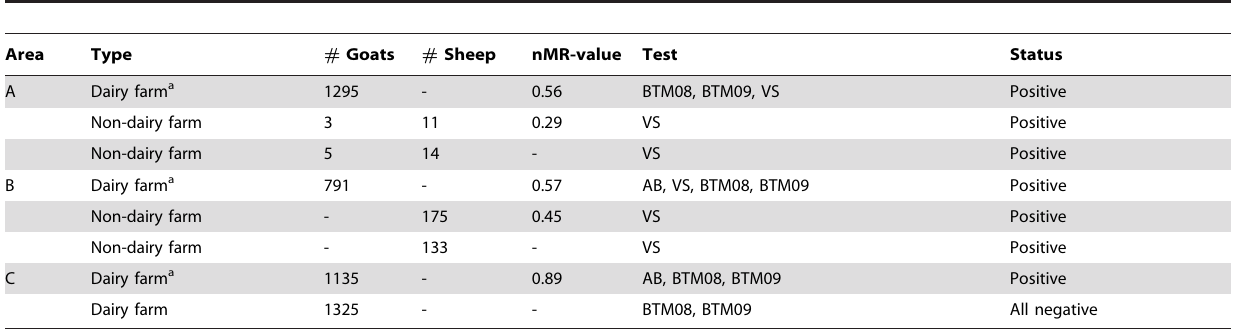
Table 1. Status information and number of goats/sheep of all dairy and non-dairy farms within the spatial grids of the areas A, B, and C that either reported abortions . 5% [9] (‘‘AB’’), or that were tested either in the BTM programs in 2008 and 2009 [8,10] (‘‘BTM08’’, and ‘‘BTM09’’), or in the non-systematical vaginal swab program [11,12] (‘‘VS’’).